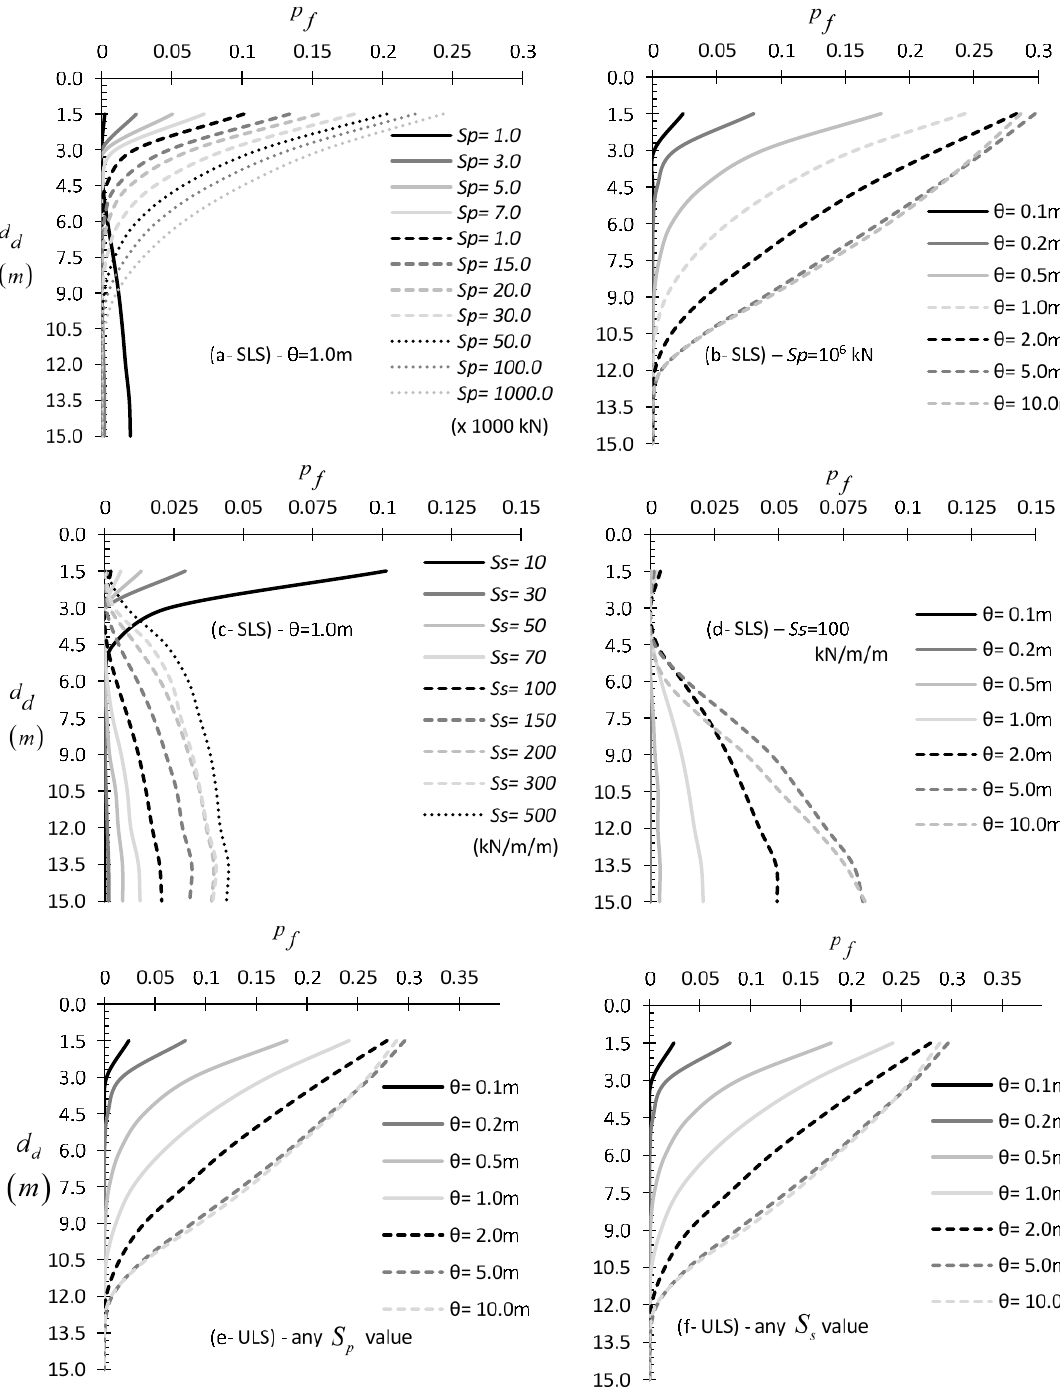
Figure 7. p f vs. d d curves for different values of ( a ) pile stiffness ( S p ) and θ =1.0 m, ( b ) spatial correlation length ( θ ) and S p =10 6 kN, ( c ) soil stiffness ( S s ) and θ =1.0 m, ( d ) spatial correlation length ( θ ) and S s =100 kN/m/m, ( e ) spatial correlation length ( θ ) (chart standing for any S p value), and ( f ) spatial correlation length ( θ ) (chart standing for any S s value). Figures ( a ) to ( d ) refer to the SLS state, whilst figures ( e ) and ( f ) to the ULS state.